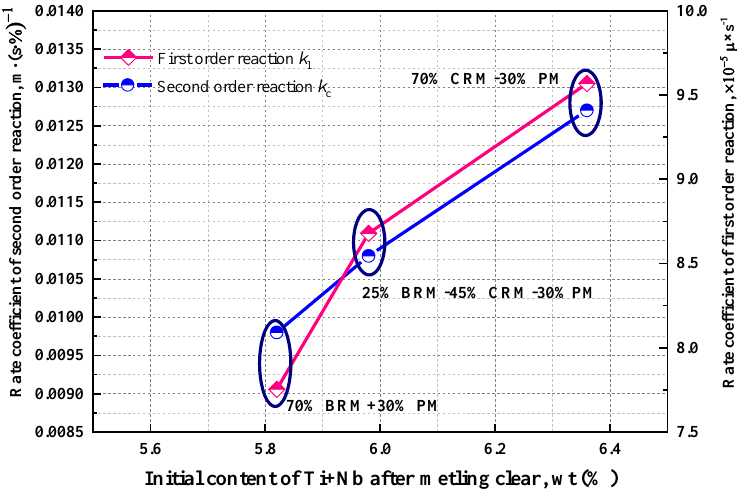
Figure 11. Mapping of a typical multiphase inclusion with a three-layer structure.